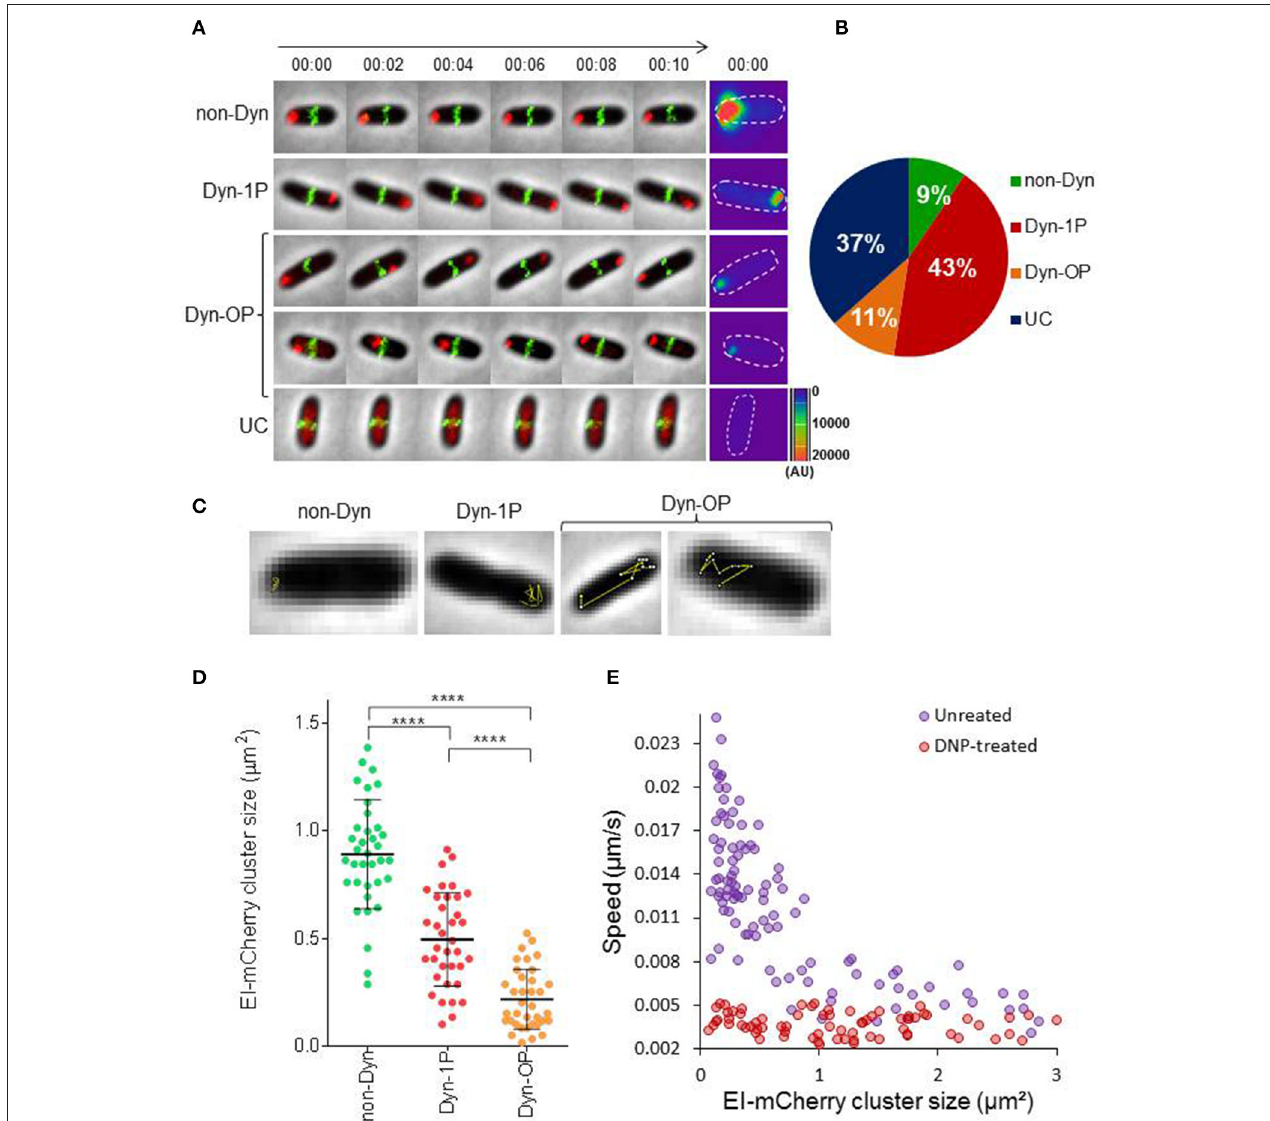
FIGURE 1 | EI is a dynamic protein whose motion is metabolism-dependent (A) Time-lapse microscopy images of wild-type E. coli cells expressing EI-mCherry and ZapA-GFP. Representative images of the four different patterns of EI dynamics are shown: (a) non-dynamic (non-Dyn), (b) dynamic within one pole (Dyn-1P), (c) dynamic between the two poles or from pole to midcell (Dyn-OP), (d) undetectable cluster (UC). The mCherry and GFP fusion proteins were observed by fluorescence microscopy and cells were observed with phase microscopy. Overlays of the fluorescence signal (GFP, green and mCherry, red) over the phase contrast images (gray) are shown. Surface intensity plots showing the fluorescent intensity (AU) of the EI-mCherry signal at time 0, which corresponds to the cellular distribution of EI-mCherry in each of the cells. The contour of each cell is outlined. (B) Pie chart showing the fractions of cells that exhibit the different patterns of EI dynamics, i.e., non-dynamic (non-Dyn, green), dynamic within one pole (Dyn-1P, red), dynamic from pole to midcell or from pole to pole (Dyn-OP, orange), and undetectable cluster (UC, blue), in populations grown to early log in minimal medium supplemented with glucose as carbon source. The Standard division was between 1 and 2%. (C) Two-dimensional trajectories of EI-mCherry cluster movement overlaid on the corresponding phase contrast (gray) images. (D) Distribution diagram indicating the distribution of EI-mCherry clusters area ( µ m 2 ) in cells (referred to as size) exhibiting the different patterns of EI dynamics (40 cells from each group). P -values were obtained by ordinary one-way ANOVA: **** p -value < 0.0001. (E) Scatter plot of cluster speed ( µ m/s) vs. EI-mCherry clusters area ( µ m 2 ), drawn for cells treated (red) or not treated (purple) with DNP. See Materials and Methods for experimental details. Spearman correlation for the untreated ρ = − 0.78, p -value < 10 − 8 .